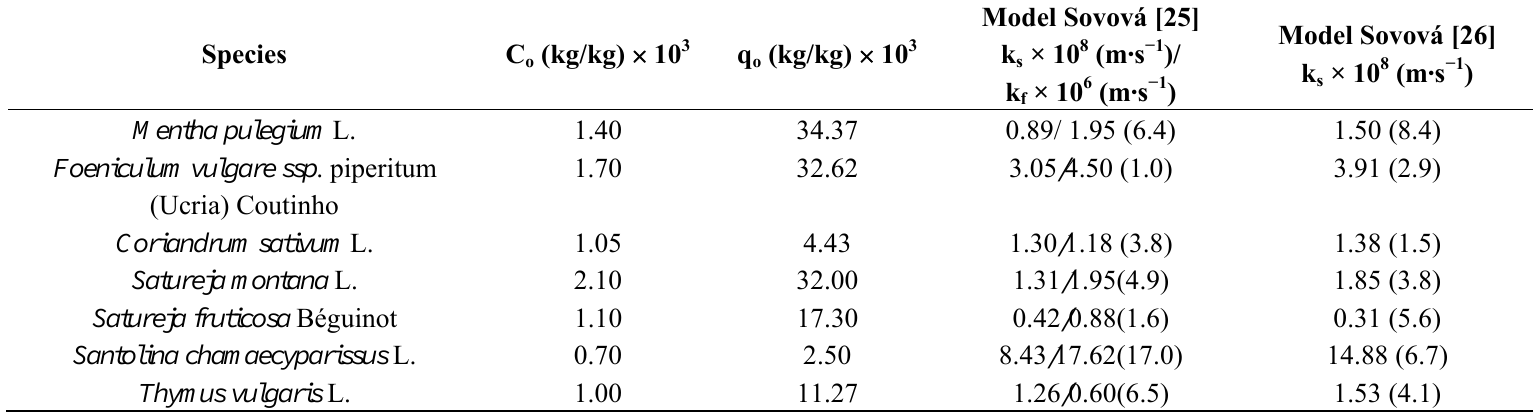
Table 7. Parameters of initial conditions for fluid (C involved in the studies with supercritical fluid extractions, in the conditions reported in Table 1 AAD% is shown within